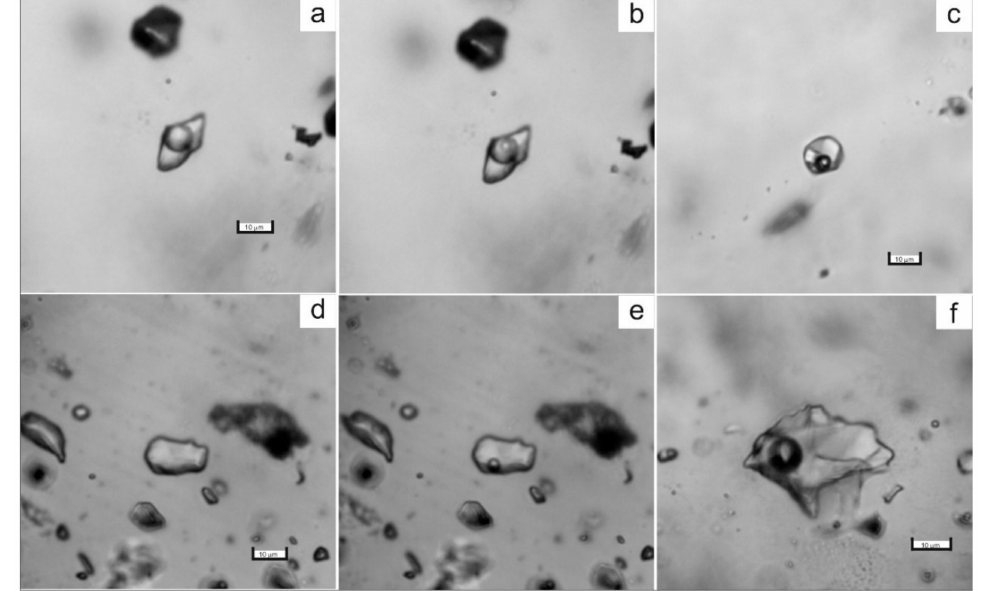
Figure 5. Photomicrographs of fluid inclusions trapped in quartz of the Svetlinsk deposit. ( a , b )—aqueous-carbonic inclusion, type I ( a —at 20 ◦ C, b —at − 10 ◦ C). ( c )—multi-phase inclusion of chloride brine, type IV. ( d , e )—vapour-rich (CO 2 ± CH 4 ± N 2 ) inclusion, type II ( d —at + 20 ◦ C, e —at − 5 ◦ C). ( f )—two-phase liquid-vapour aqueous inclusion, type